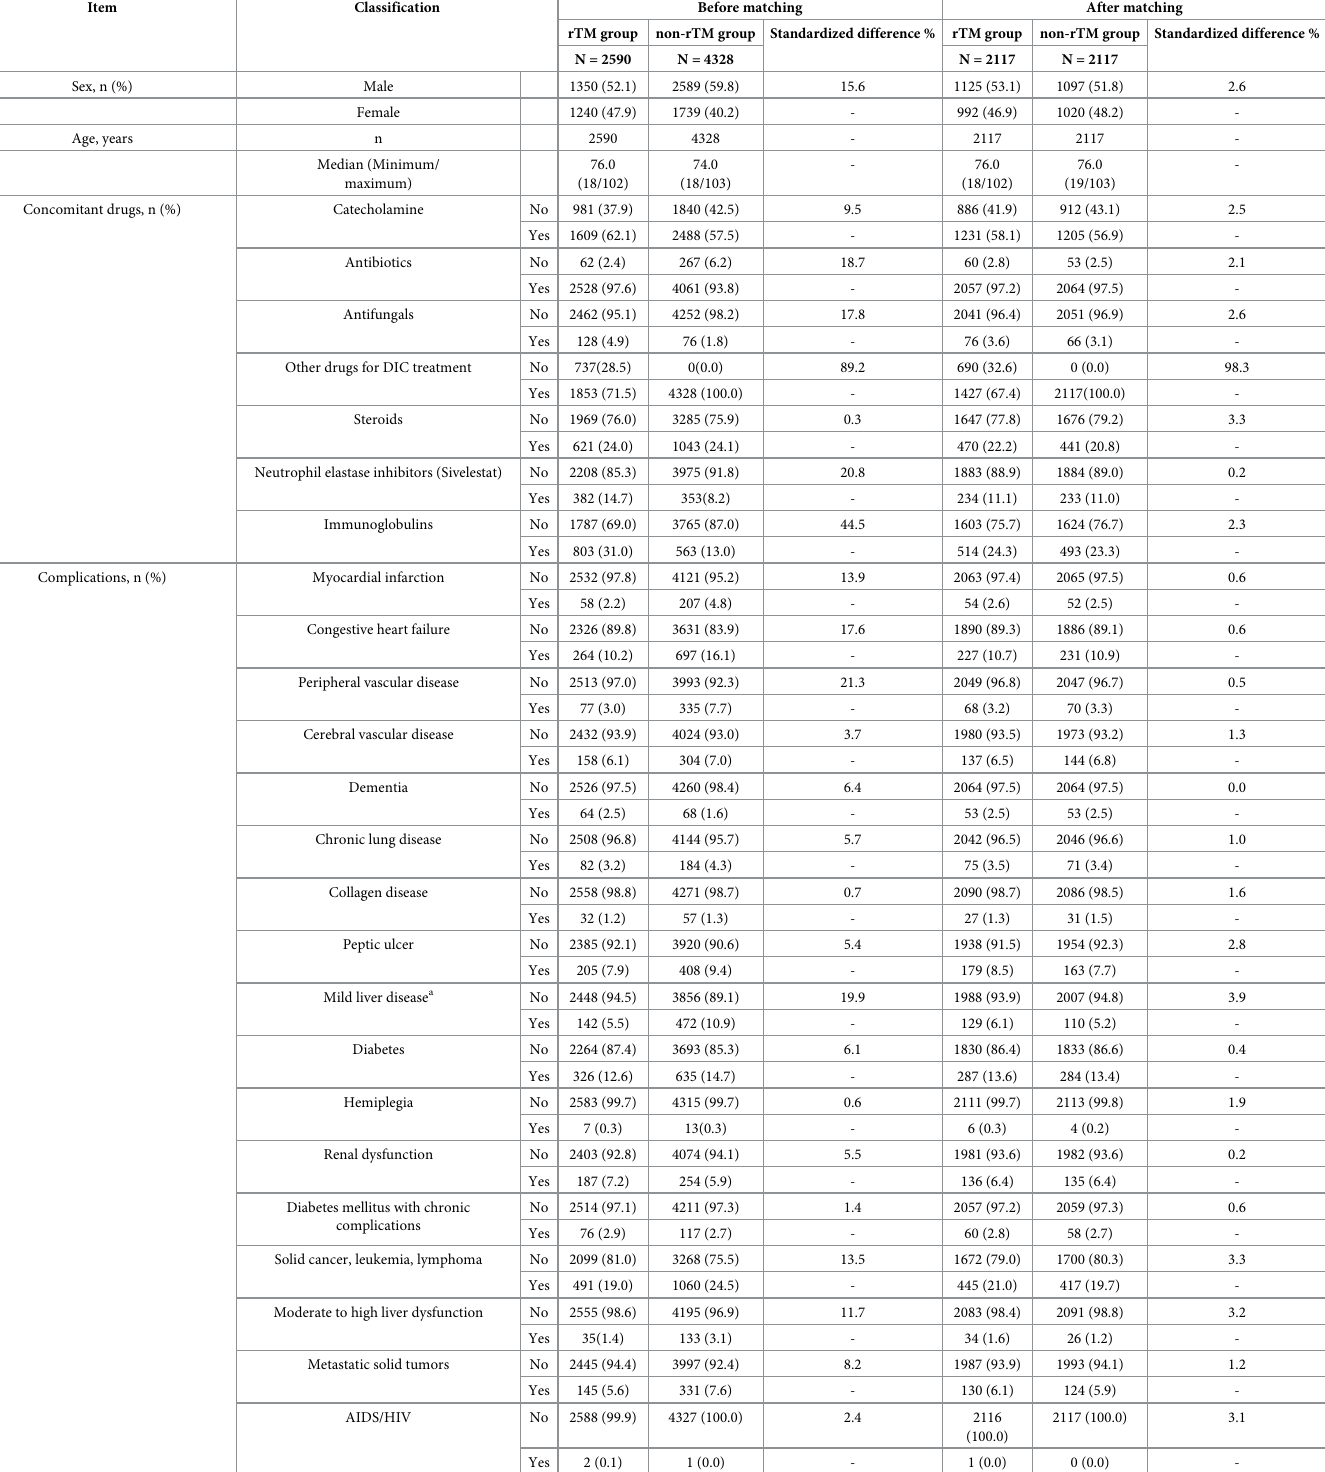
Table 1. Demographic and clinical baseline